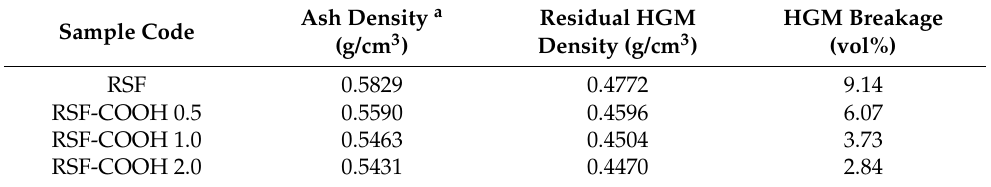
Table 5. HGM breakage measurement results of each RSF composite containing various HBP